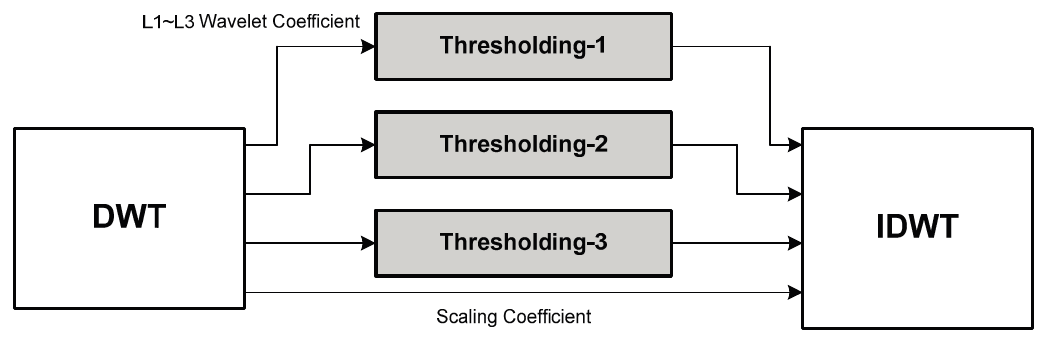
Figure 8. The second stage architecture of 1D IDWT.